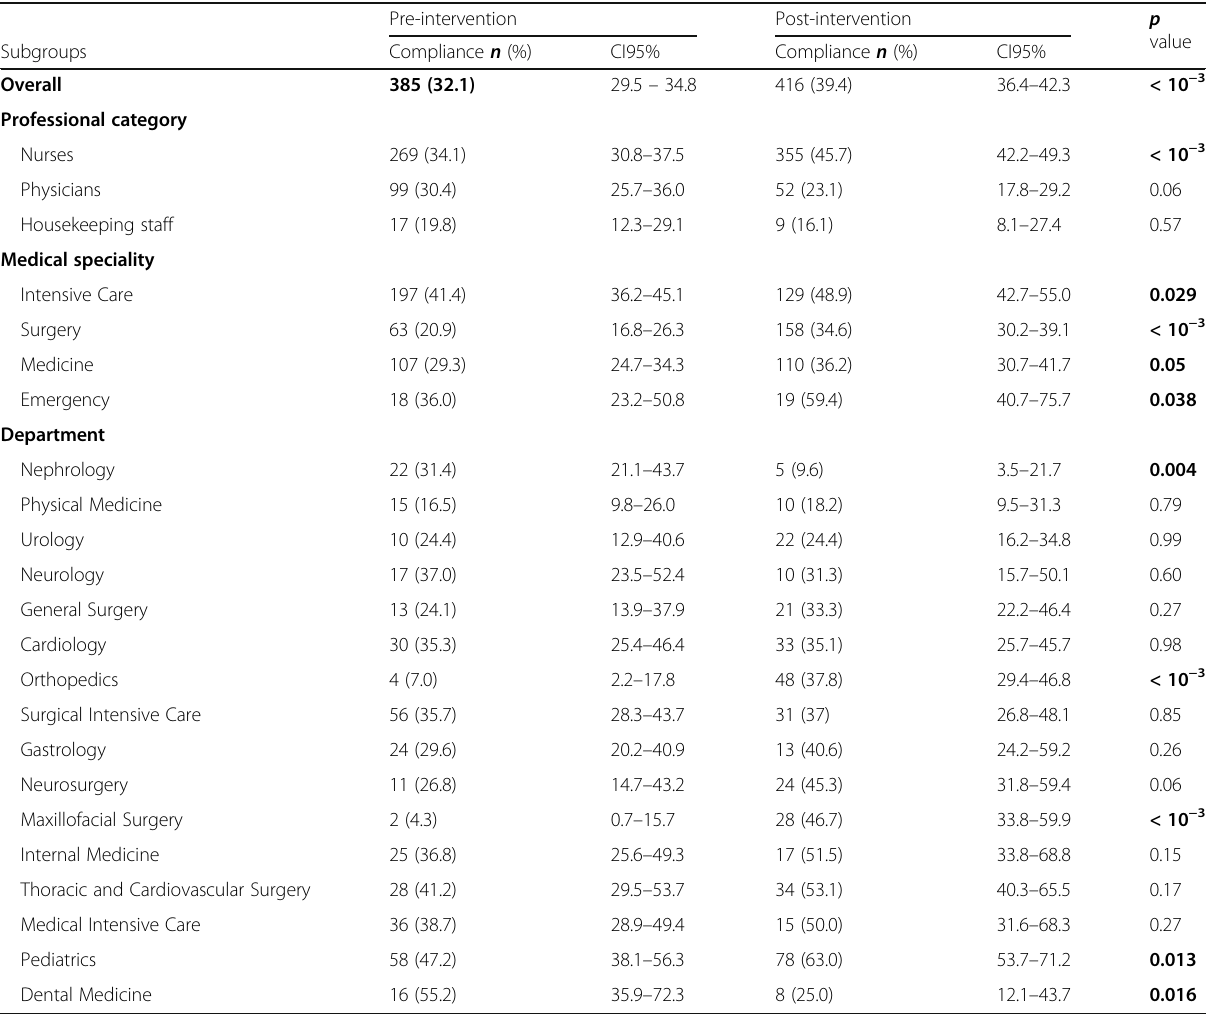
Table 1 Hand hygiene compliance among health care professionals, before and after intervention, at University Hospital Sahloul, Sousse, Tunisia 2015 –